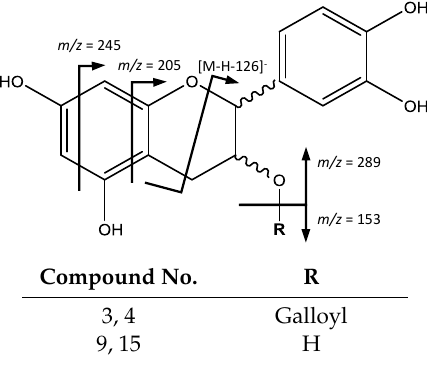
Figure 3. Flavan-3-ols monomers and gallates structure and main fragments.